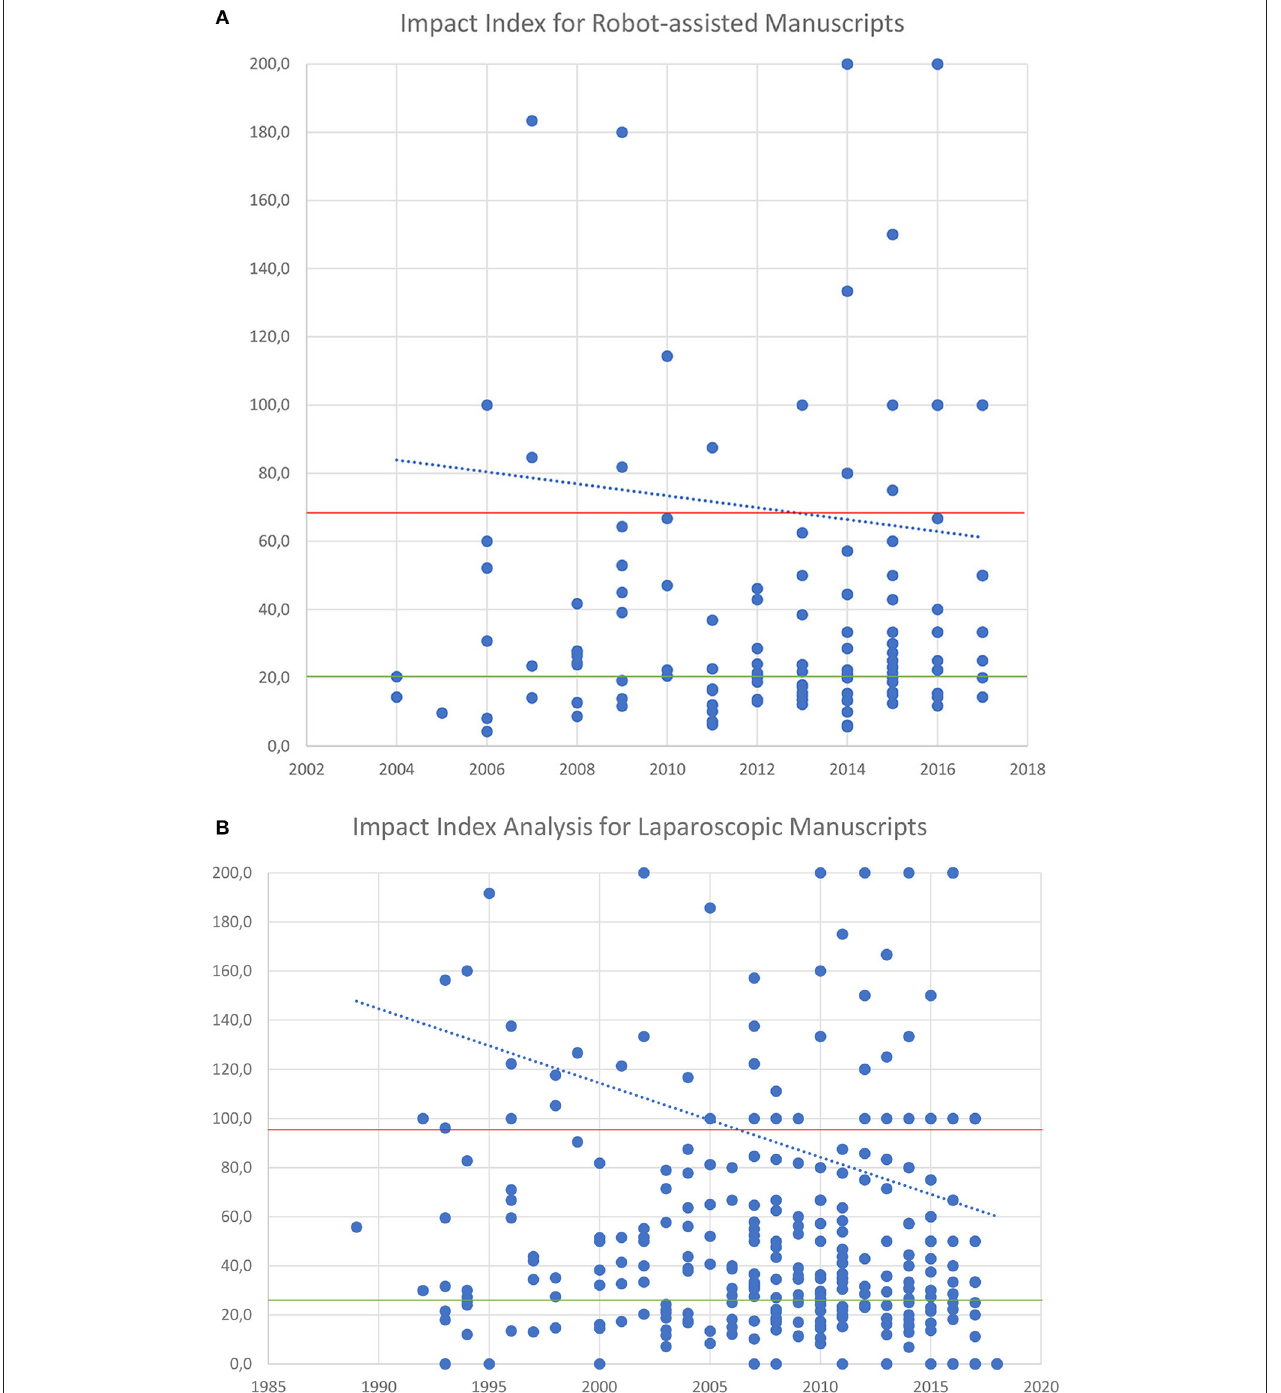
FIGURE 4 | (A) Impact Index analysis per manuscript over time for RAS. (B) Impact Index analysis per manuscript over time for Laparoscopy. In red average Impact Index and green average citations per manuscript. In blue the trend of Impact index over